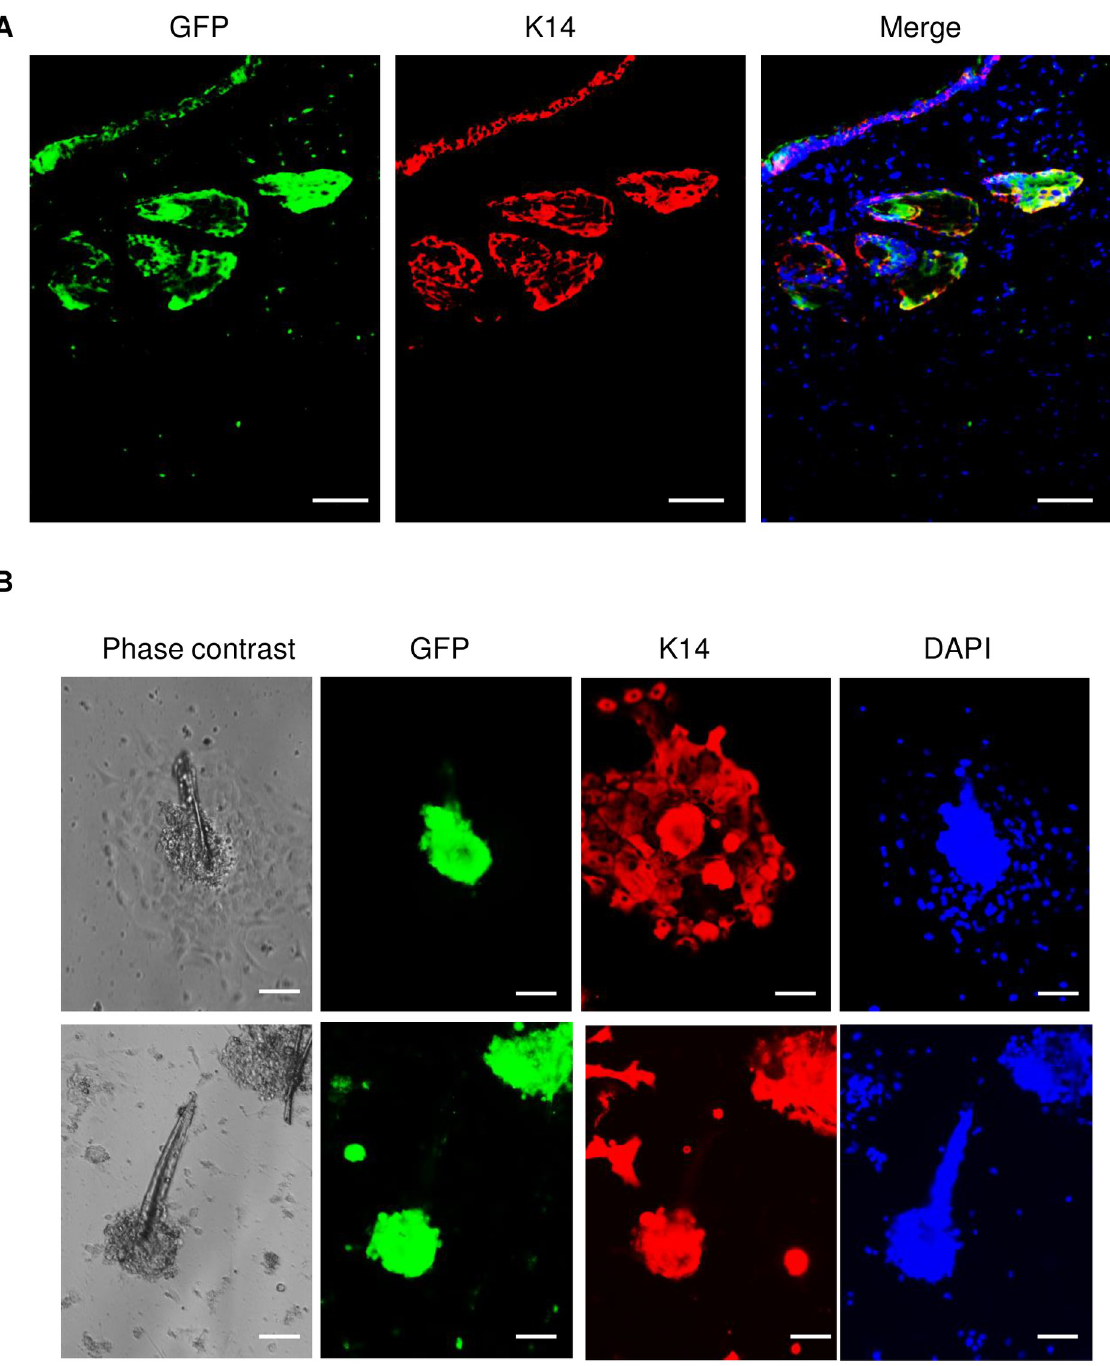
Fig 7. Detection of GFP-expressing myeloid cells in new forming hair follicle in wounded skin of mice. ( A ) Double immunofluorescent staining with keratin-14 (K14) (red) and GFP (green) antibodies in wounded skin of mice which received one million GFP-expressing splenocyte-derived myeloid cells for 4 weeks. ( B ) Double immunofluorescent staining with keratin-14 (K14) (red) and GFP (green) antibodies in cultured hair follicles isolated from the edge of wounds in mice received one million GFP-expressing myeloid cells for 4 weeks. DAPI (blue) was used as a nuclear counterstain. Scale bars in all images was 50 μ